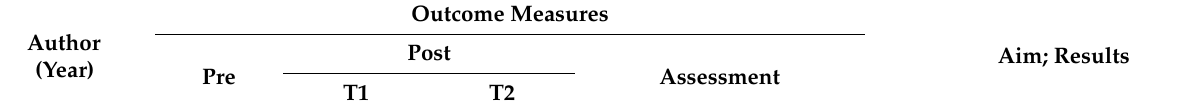
Table 5. Summary of results of the included